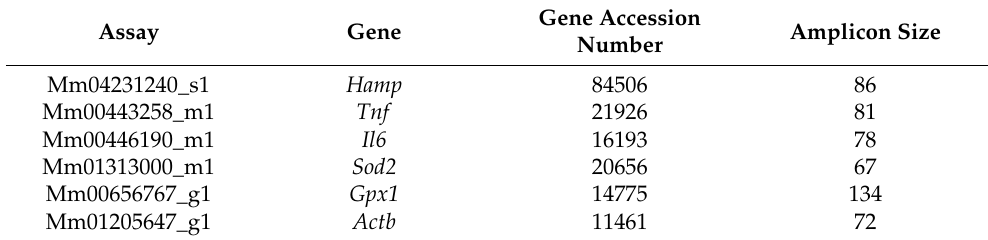
Table 4. qRT-PCR primer and probe